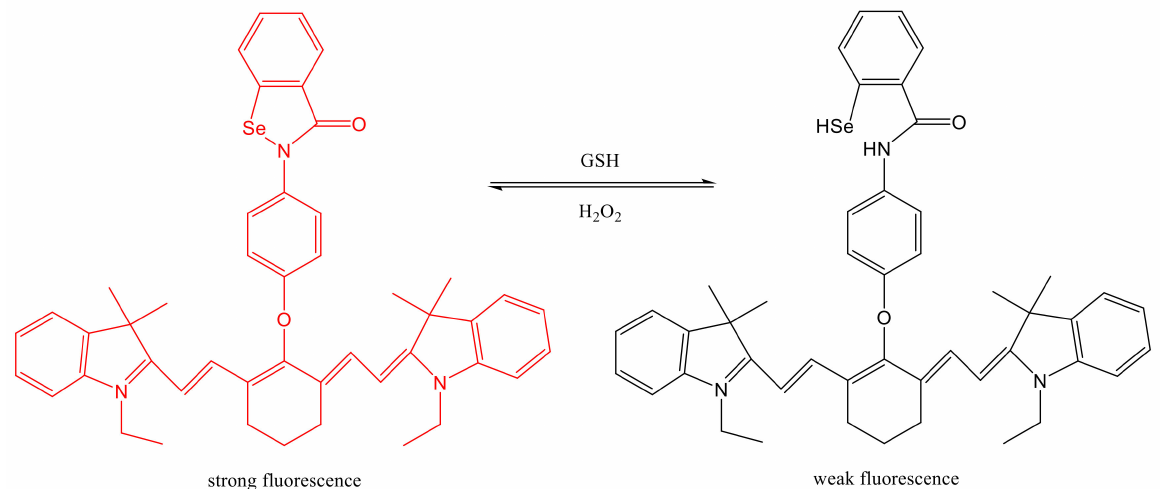
Figure 7. Dual reaction of probe (Cy-O-Eb) with GSH/H 2 O 2 [81]. The Se-N bond (strong fluorescence) in Cy-O-Eb was reduced with GSH to form Se-H bond (weak fluorescence). Se-N was regenerated and the fluorescence was restored under the effect of H 2 O 2